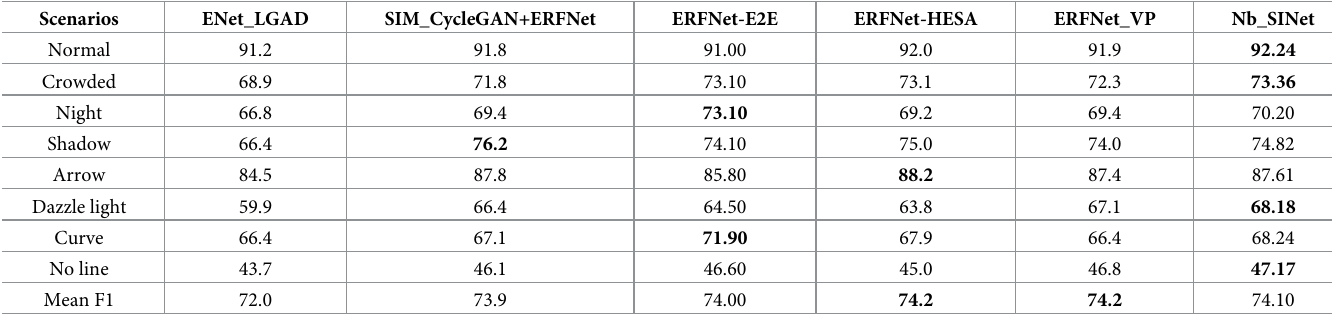
Table 5. F1 index for each model in different